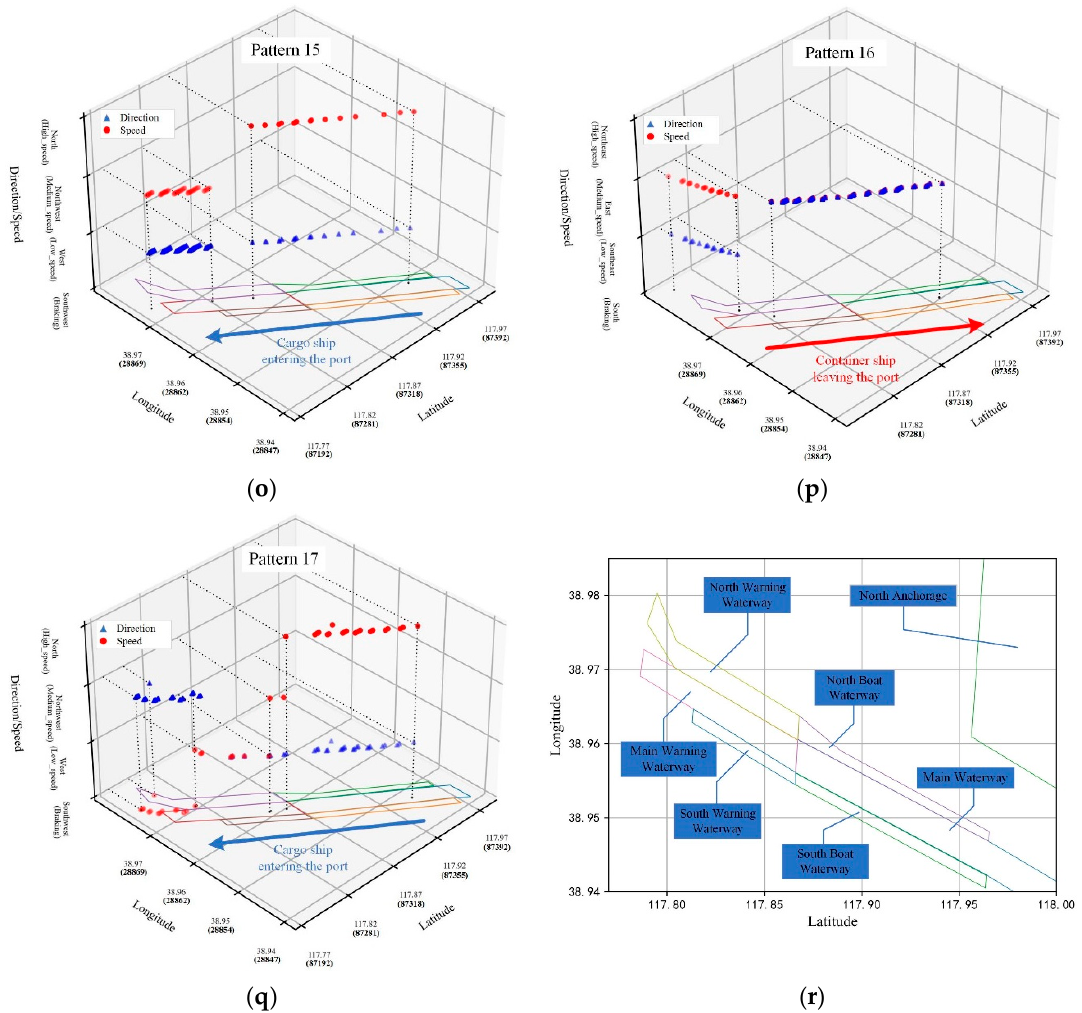
Figure 11. Visualization of the spatial distribution of high-frequency motion words for 17 motion pattern topics in Tianjin Port. ( a ) Topic 1; ( b ) Topic2; ( c ) Topic 3; ( d ) Topic 4; ( e ) Topic 5; ( f ) Topic 6; ( g ) Topic 7; ( h ) Topic 8; ( i ) Topic 9; ( j ) Topic 10; ( k ) Topic 11; ( l ) Topic 12; ( m ) Topic 13; ( n ) Topic 14; ( o ) Topic 15; ( p ) Topic 16; ( q ) Topic 17; ( r ) Overhead view of the Tianjin Port waterway.